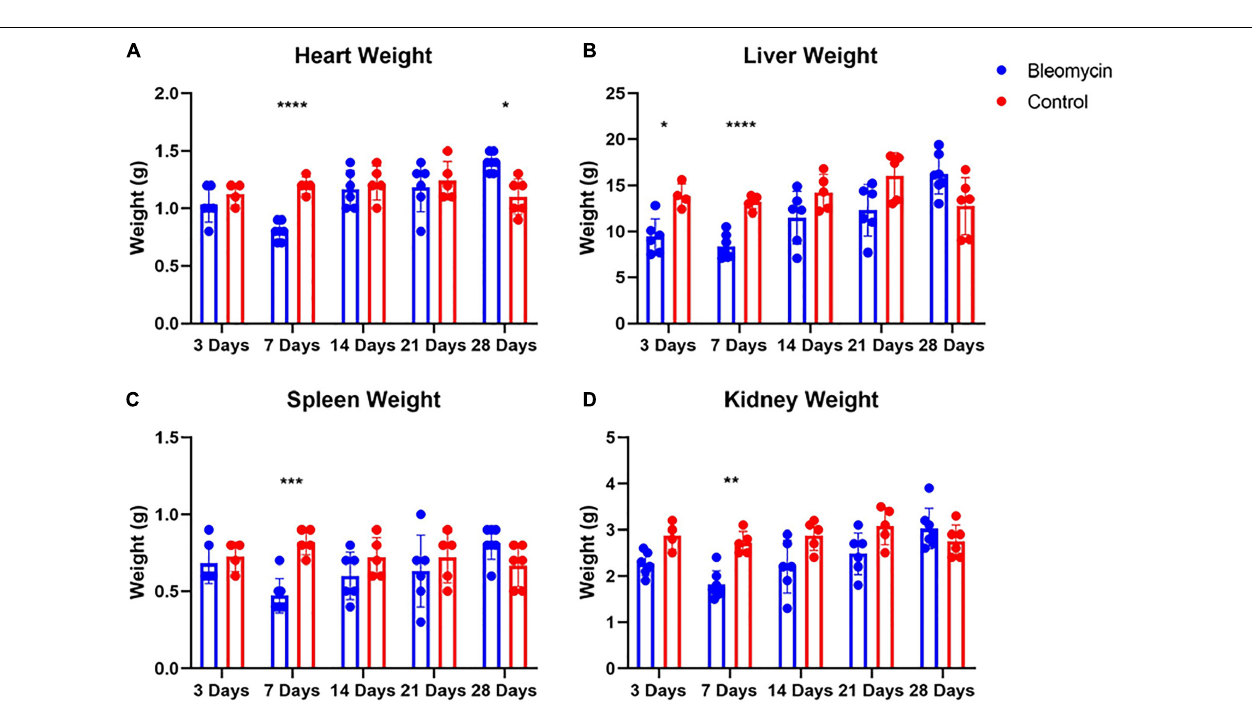
Frontiers in Physiology |